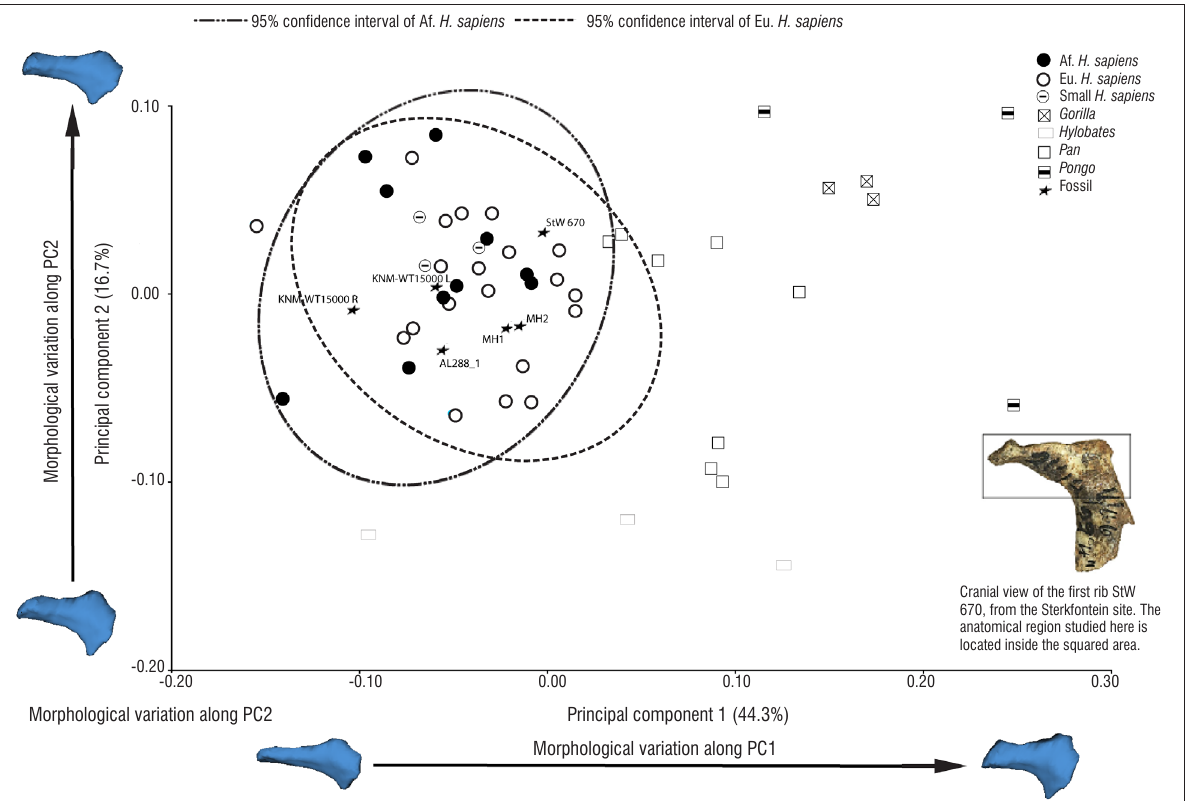
Principal component 1 (44.3%)